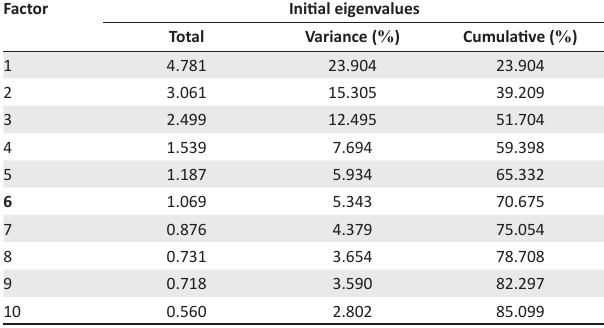
TABLE 4: Extract table of factor analysis for media synchronicity.